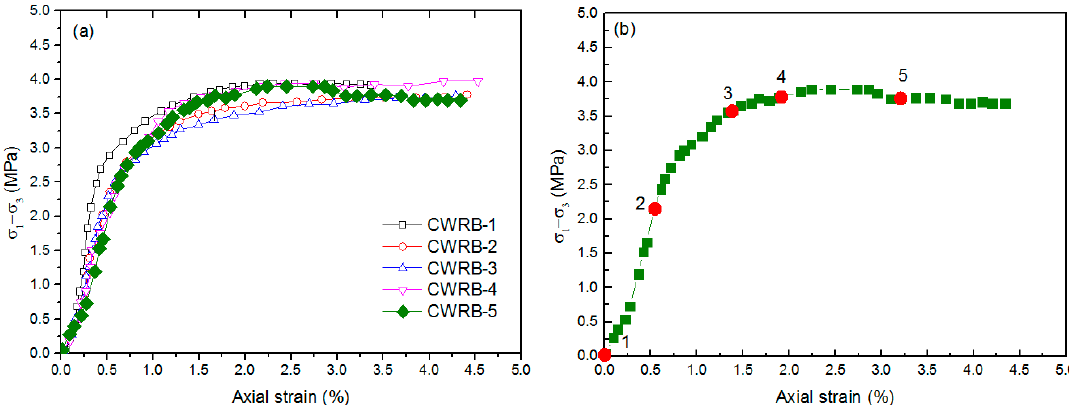
Figure 7. The axial stress–strain curves of the CWRTB sample under triaxial compression. ( a ) Macroscopic stress–strain curve for five CWRTB samples; ( b ) determination of the CT scanning stages for the CWRTB sample.